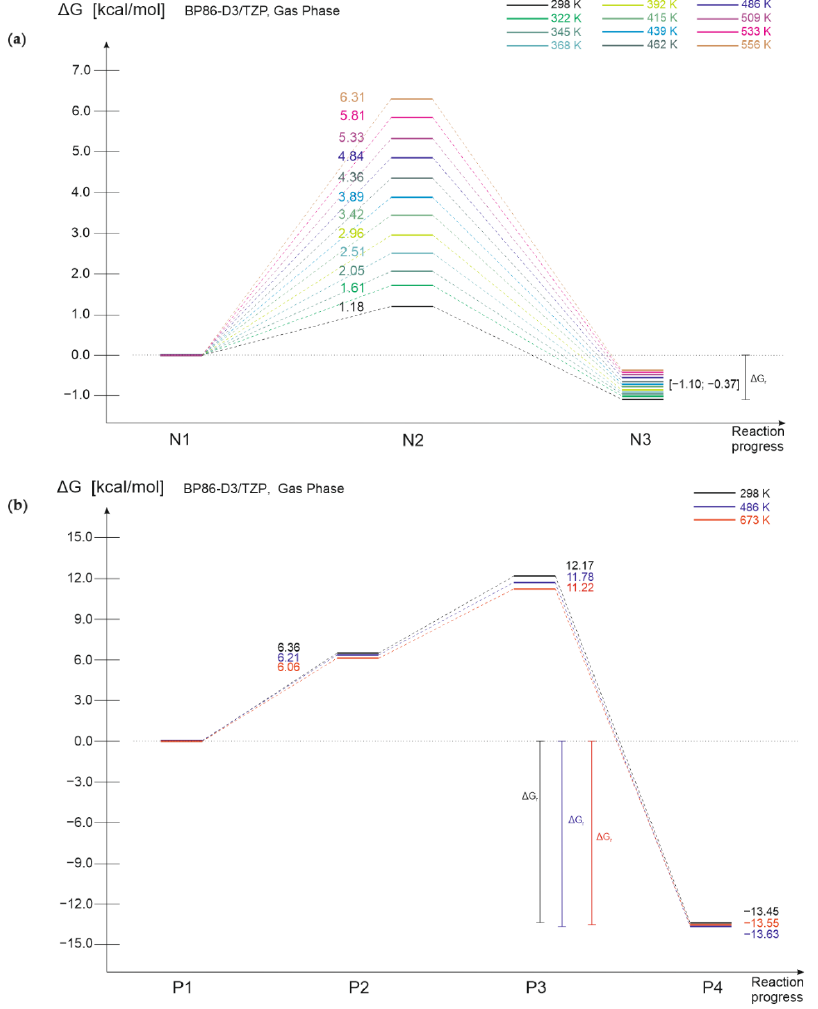
Figure 9. Relative Gibbs free energies of ( a ) nylon 6 and ( b ) PHB structures obtained in different temperatures in gas phase; some of the data was neglected aiming the clarity of the picture.